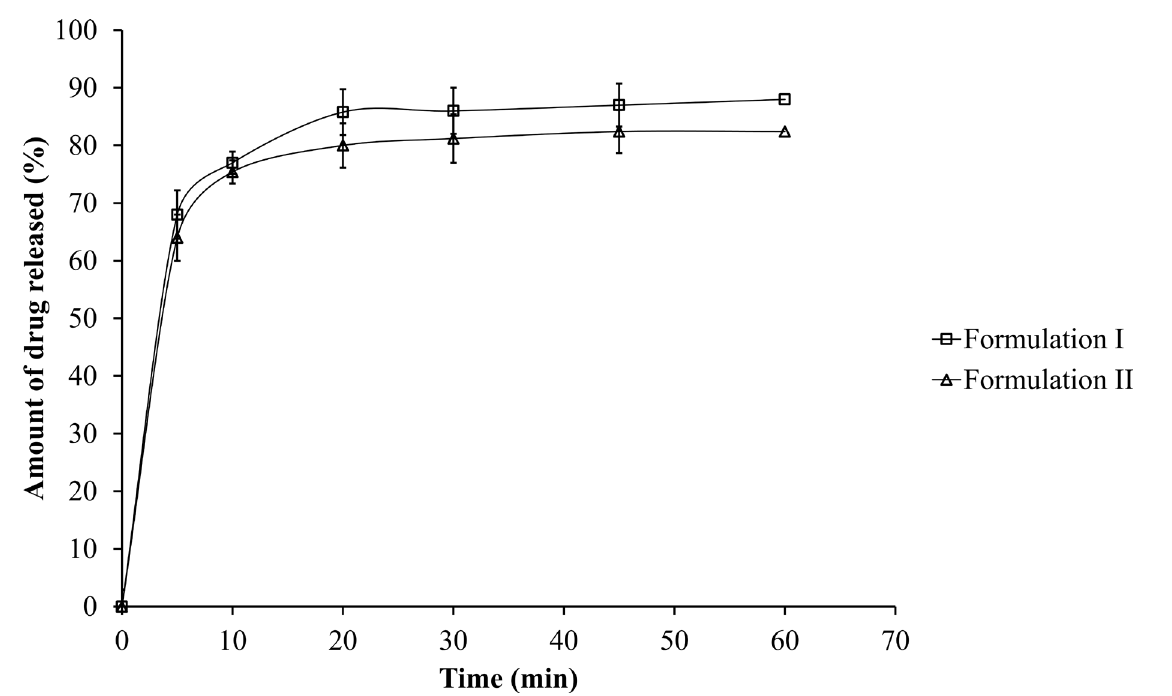
FIGURE 4 - Drug-release profile of formulations I and